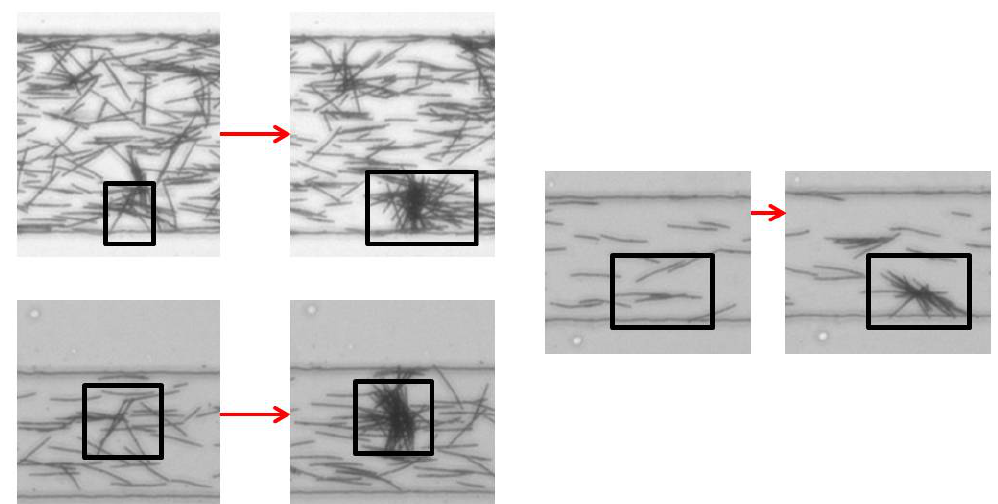
Figure 17. Three cases of fiber clustering. The first picture is taken before the formation of the cluster. One can note the orientations of the fibers in the cluster, mostly perpendicular to the flow direction. The channel width is 100 µ m. The corresponding video is available in Supplementary Materials Video S8.